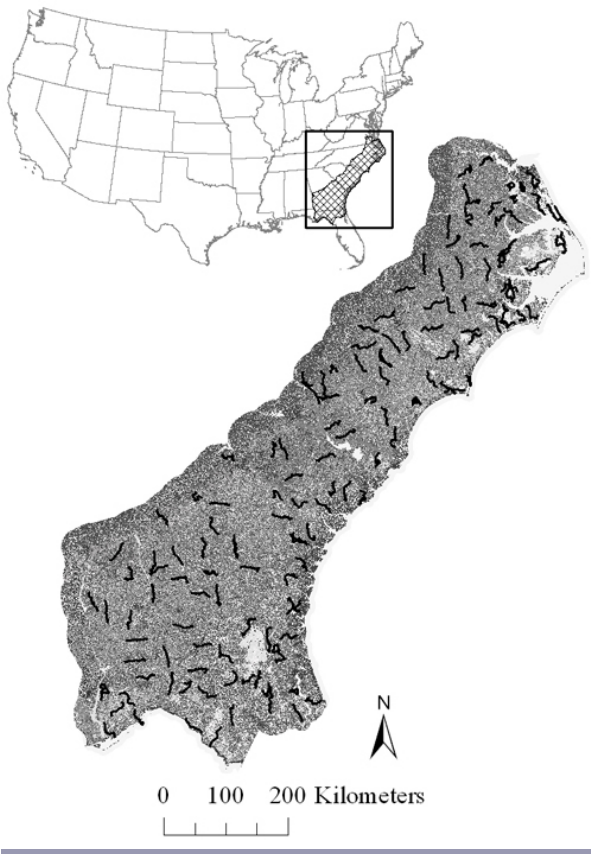
Fig. 1 . Location of 120 North American Breeding Bird Survey routes used in occupancy modeling for three avian species in the South Atlantic Coastal Plain region, United States,